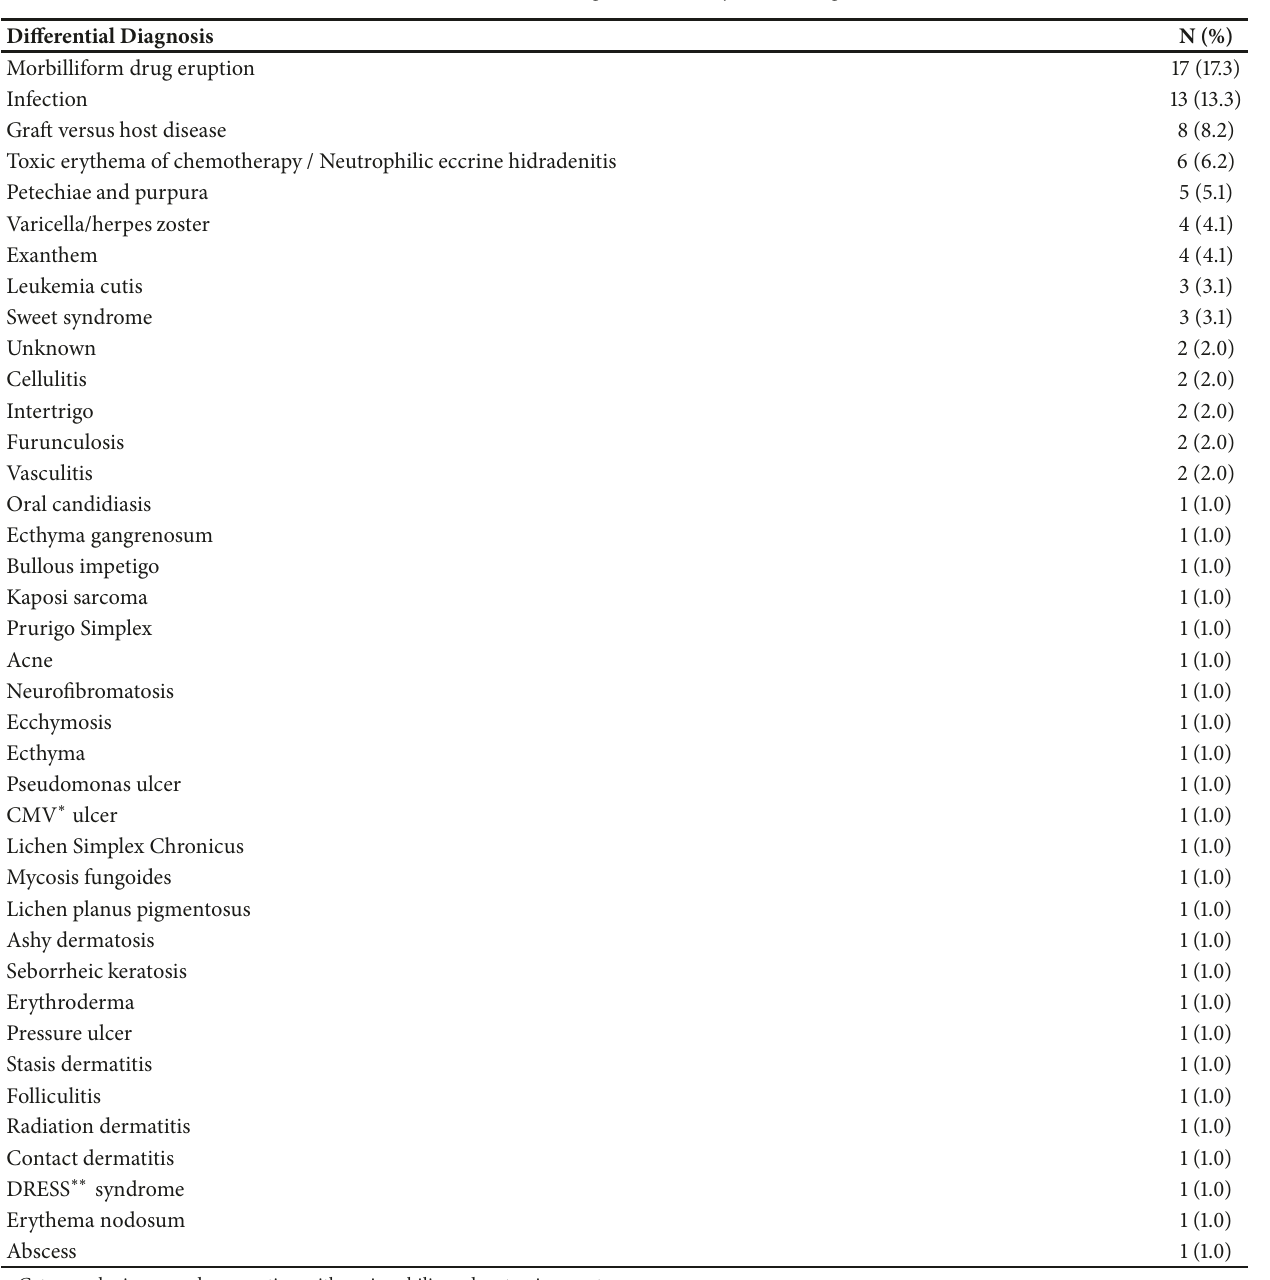
Table 2: Differential diagnoses made by